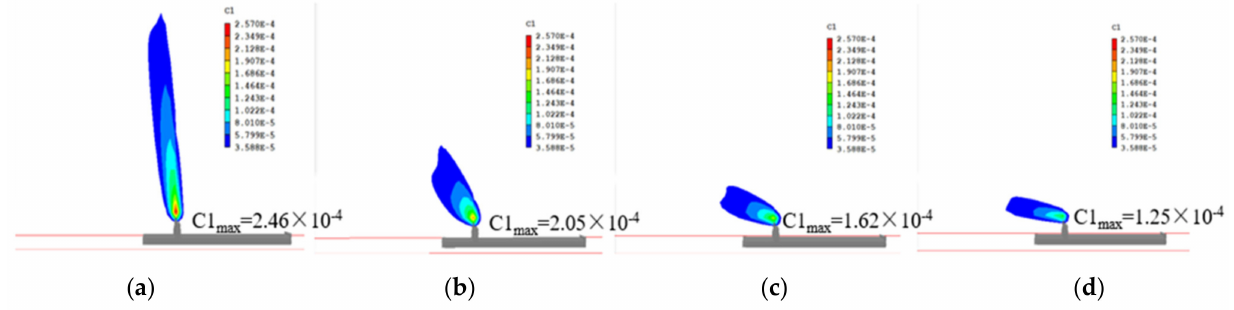
Figure 4. BL1 simulations: The contours of C1 (mass fraction of SO 2 in the plume) on the M1 plane at different wind speeds: ( a ) V wind = 5 m/s; ( b ) V wind = 10 m/s; ( c ) V wind = 15 m/s; ( d ) V wind = 20 m/s.